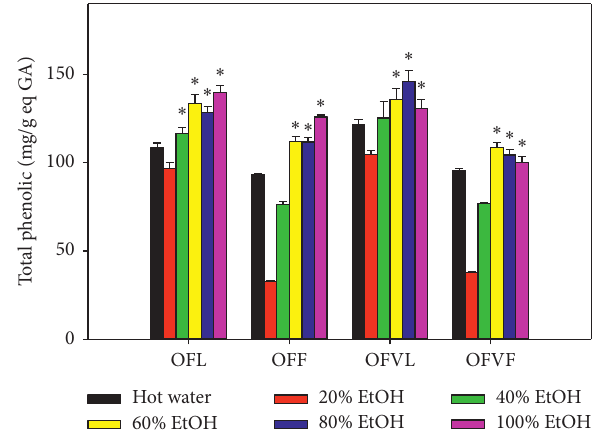
Figure 3: Acteoside contents in Osmanthus fragrans leaves (OFL), O. fragrans flowers (OFF), O. fragrans var. aurantiacus leaves (OFVL), and O. fragrans var. aurantiacus flowers (OFVF) ( n � 3; ∗ significantly higher than the “hot water” extract).